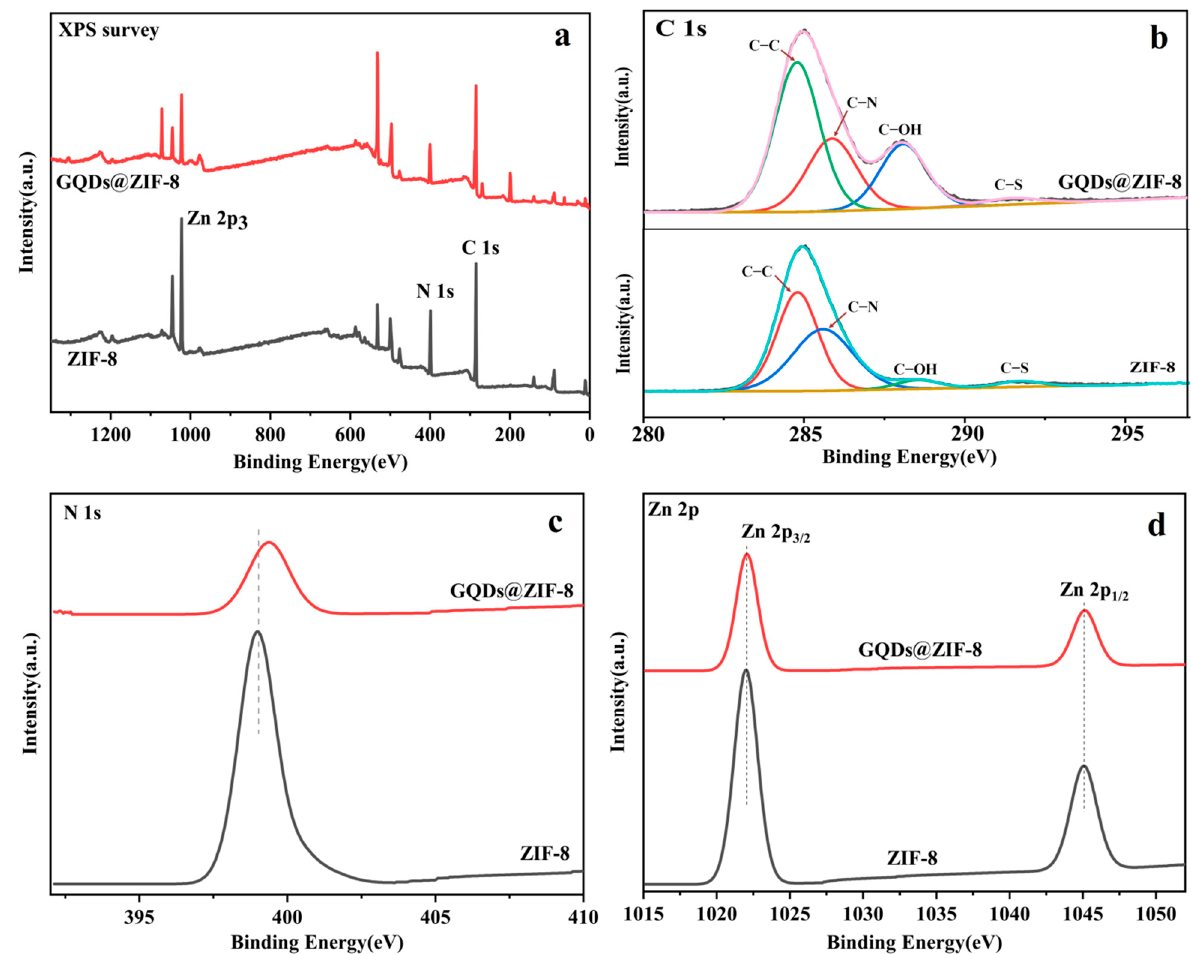
Figure 5. XPS survey spectra of ZIF-8 and GQDs@ZIF-8 composites ( a ), C 1s spectra with the colorful curves representing the characteristic peaks of C–C, C–N, C–O and C–S, respectively ( b ), N 1s spectra ( c ), Zn 2p spectra ( d